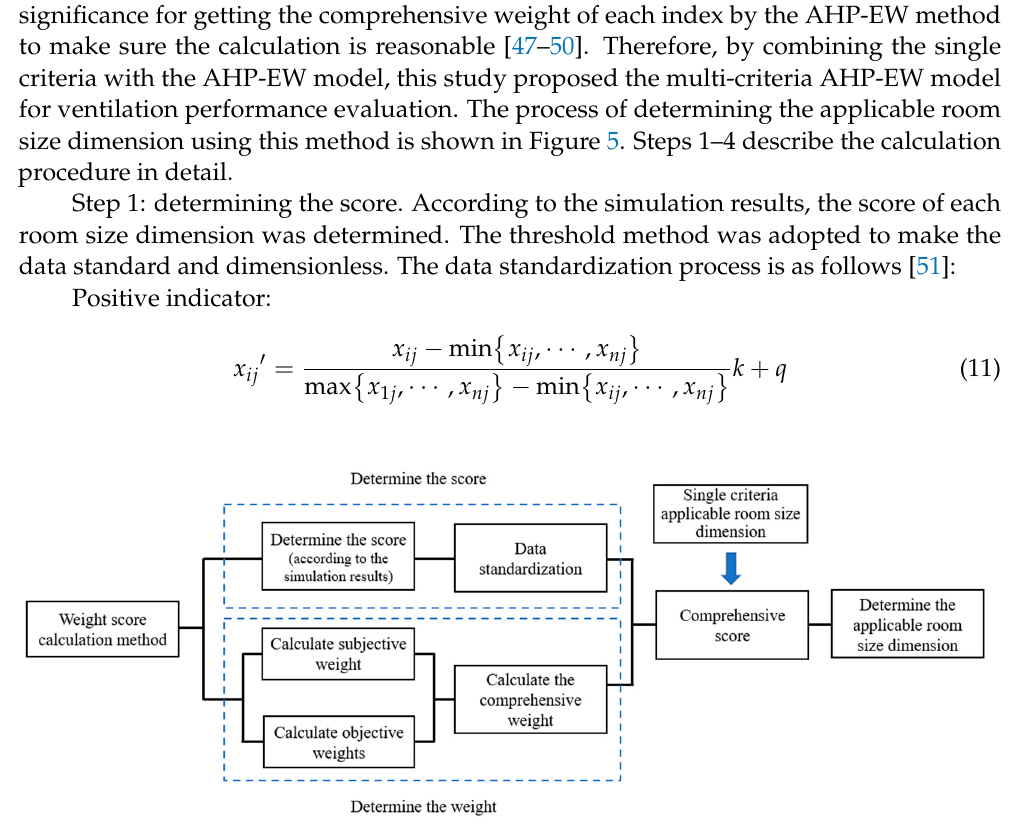
Figure 5. Process to determine the applicable room size dimension.